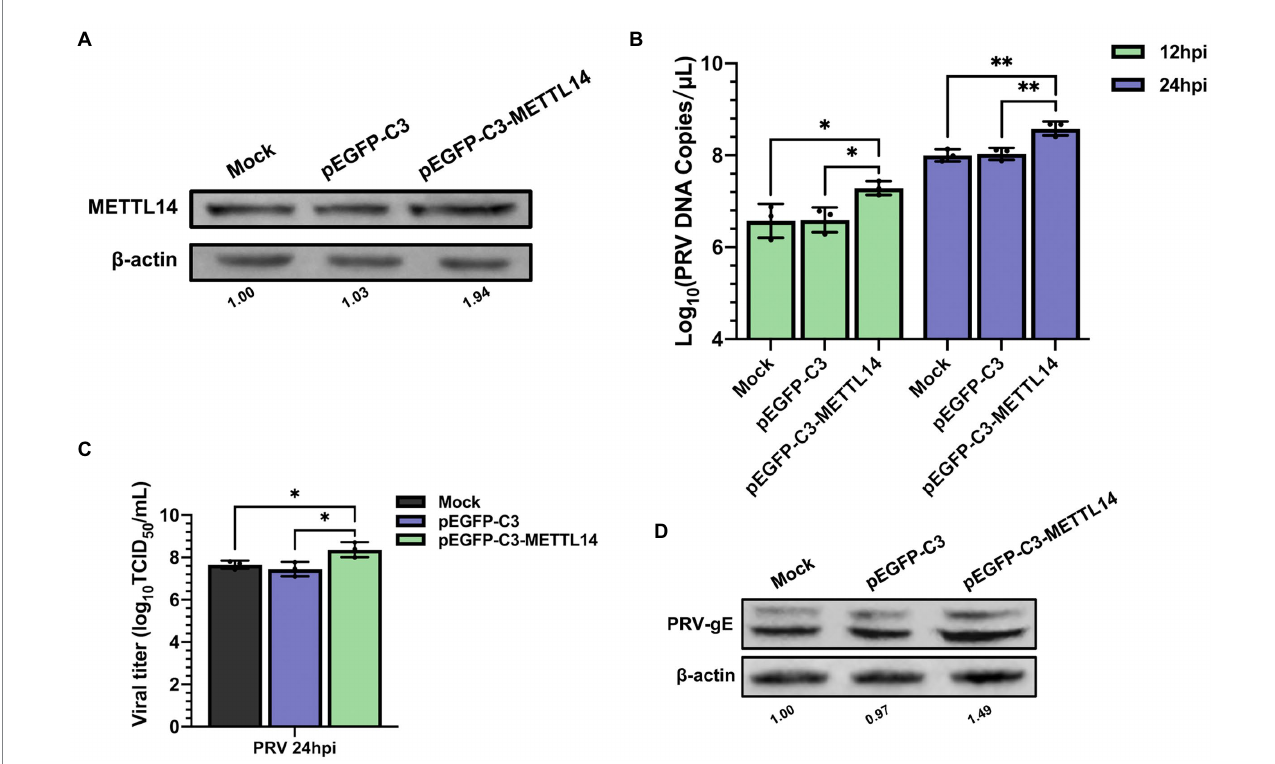
FIGURE 5 Overexpression of METTL14 promoted PRV proliferation. (A) PK15 cells were transfected with pEGFP-C3 and pEGFP-C3-METTL14 (2.5 μ g) for 6 h, and then cultured with fresh maintenance medium for 24 h. METTL14 was assessed by immunoblotting analysis. β -actin was used as a loading control. (B) PK15 cells were transfected with pEGFP-C3 and pEGFP-C3-METTL14 (2.5 μ g) for 6 h, and then cultured with fresh maintenance medium for 24 h. PK15 cells were infected with PRV-FJ01 (MOI = 0.1) for 12 and 24 h. PRV DNA copies were evaluated by RT-qPCR analysis. (C) PK15 cells were transfected with pEGFP-C3 and pEGFP-C3-METTL14 (2.5 μ g) for 6 h, and then cultured with fresh maintenance medium for 24 h. PK15 cells were infected with PRV-FJ01 (MOI = 0.1) for 24 h. PRV titers were assessed by TCID 50 analysis. (D) PK15 cells were transfected with pEGFP-C3 and pEGFP-C3-METTL14 (2.5 μ g) for 6 h, and then cultured with fresh maintenance medium for 24 h. PK15 cells were infected with PRV-FJ01 (MOI = 0.1) for 24 h. PRV gE was assessed by immunoblotting analysis. β -Actin was used as a loading control. * p < 0.05, ** p <